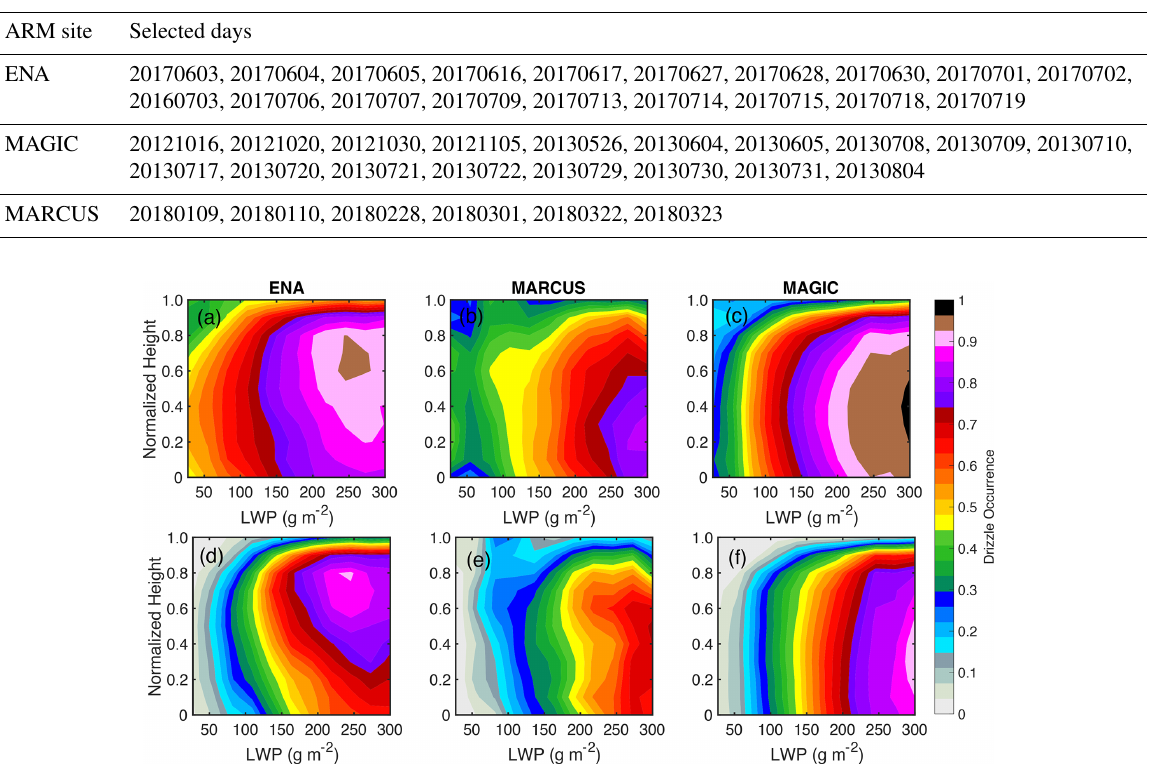
Table 2. Selected stratocumulus days in the ACE-ENA, MAGIC and MARCUS campaigns.